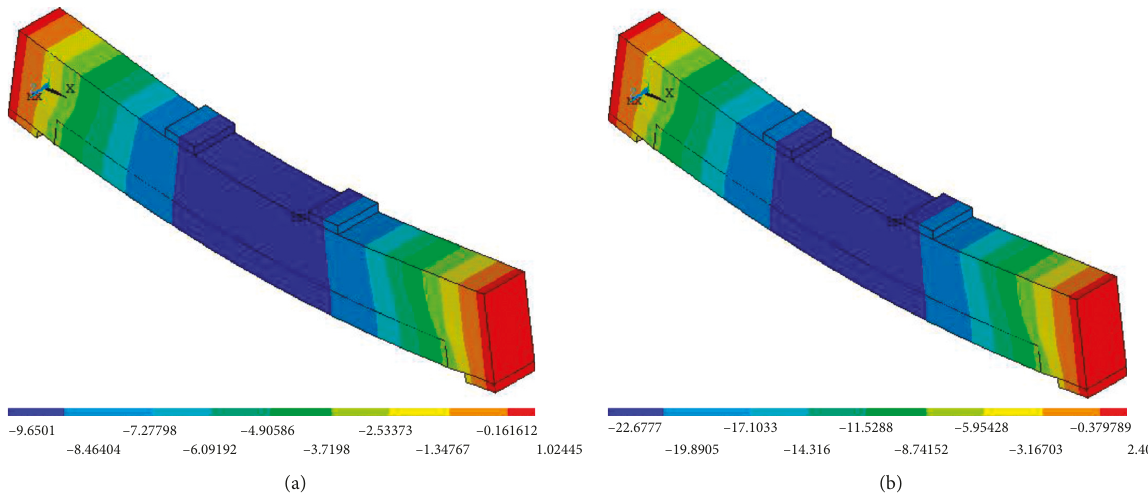
Figure 16: 3D views of deflections in the B8 model at (a) the yield load stage and (b) the maximum load